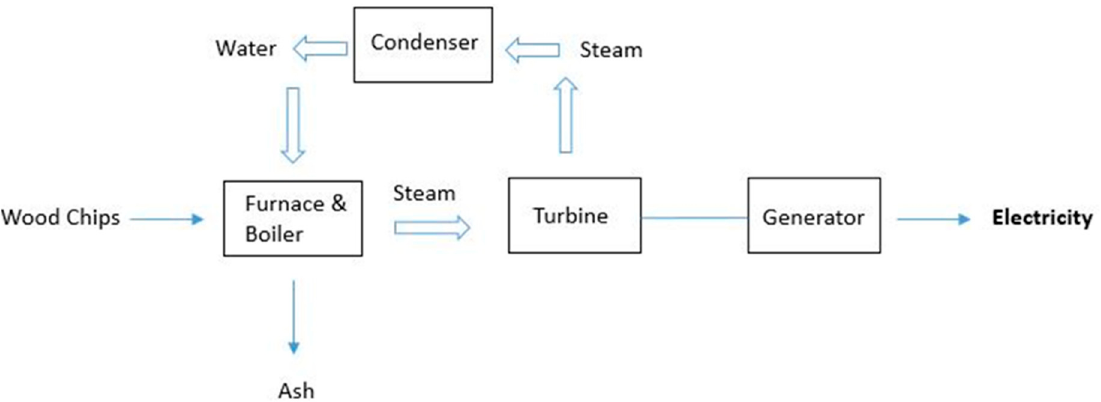
Figure 5. Schematic diagram for utility-scale power production.